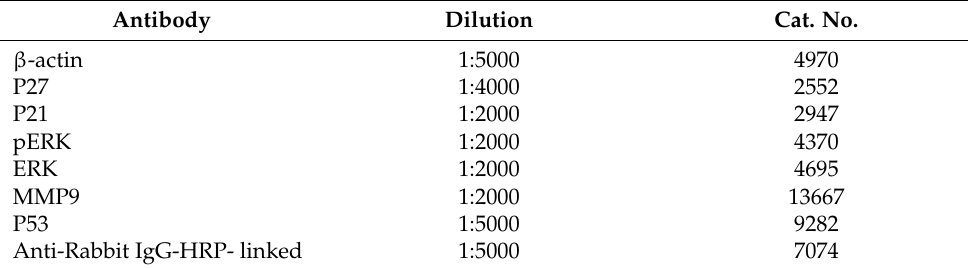
Table 5. Antibodies used in the